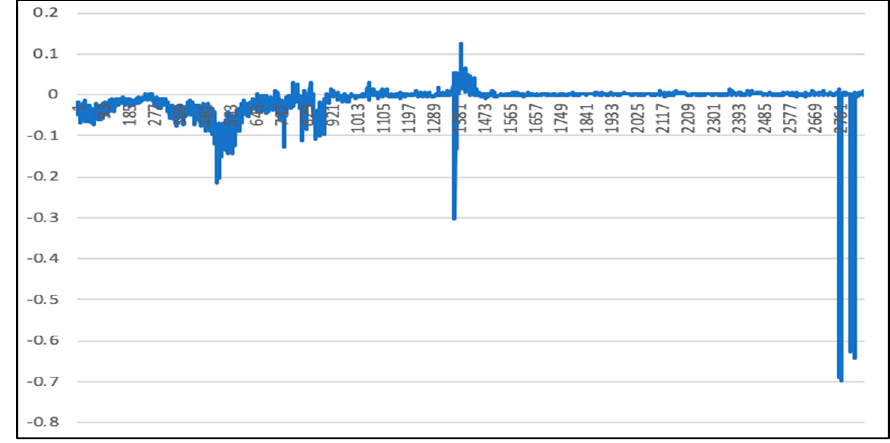
Figure 28. Error map of LSTM-SVR II prediction results and actual results (first 2850 data).